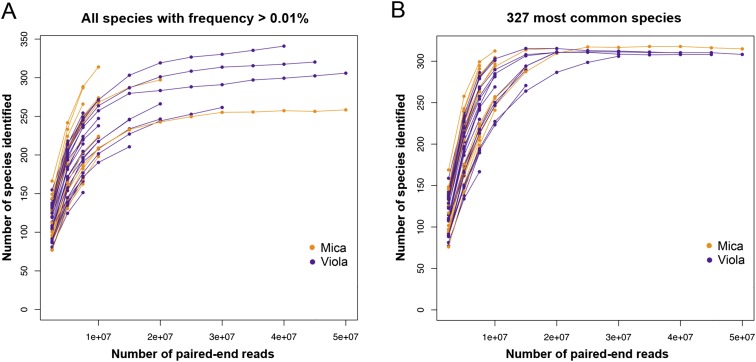
Rarefaction analyzes of shotgun metagenomic data.Plot (A) shows the number of species found in each sample as a function of the number of paired-end reads down-sampled from the full data set. The number of species reported in each data point corresponds to the average number of species over 10 randomly resampled data sets (restricted to species detected at an abundance >0.01% in the sample, based on the logic that very rare species are more likely to represent assignment errors). In each random re-sampling, we down-sampled the number of reads and re-ran the subsampled sequences through the MetaPhlAn 2.0 pipeline to obtain a count of the number of species represented in each down-sampled data set. Plot (B) depicts a parallel analysis to (A), but limited to the 327 most prevalent species in our data set.